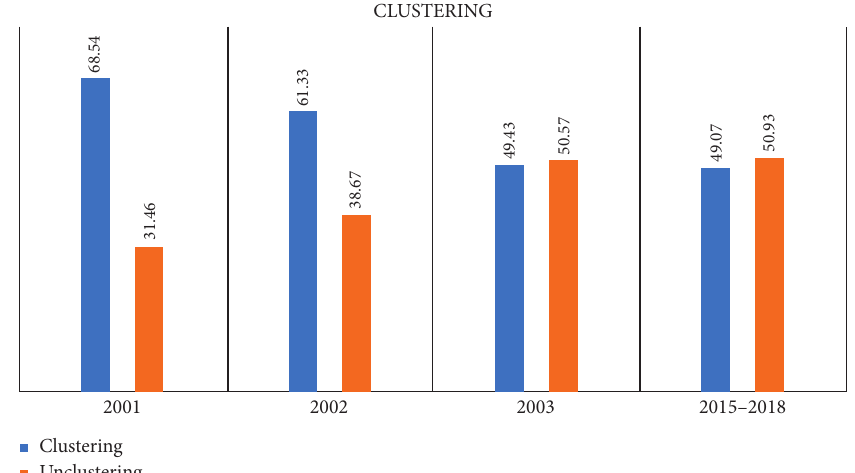
Figure 2: Clustering pattern between the years 2001 and 2018, showing a decrease in clustering, which correlates with an increase in the orphan strains in the